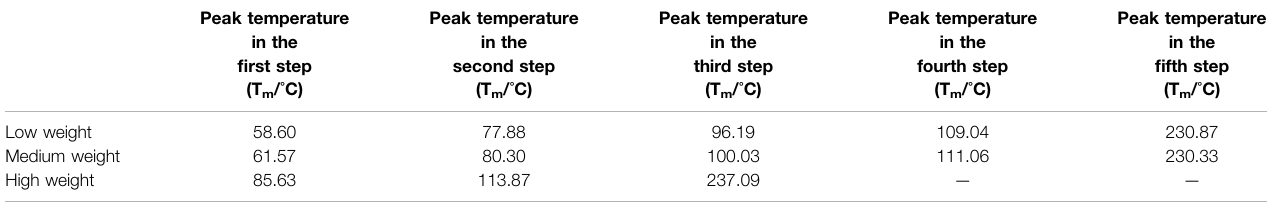
TABLE 1 | Peak temperature data of chalcanthite with different weights obtained according to the thermogravimetry curve corresponding to the differential thermal peak.